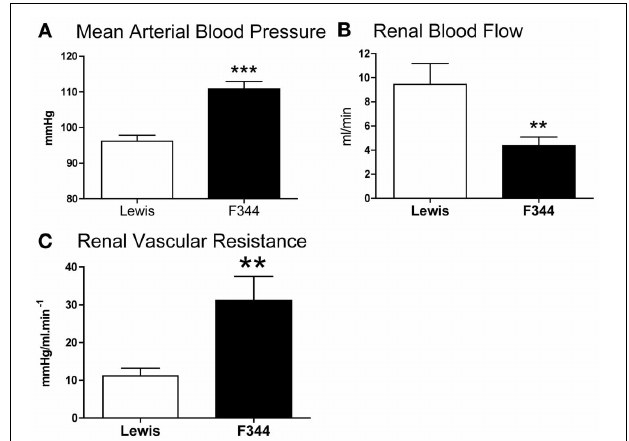
FIGURE 1 | (A) Mean arterial blood pressure; (B) left renal artery blood flow and (C) renal vascular resistance in the left renal artery measured in Lewis ( n = 8; open bars) and F344 ( n = 7; black bars) rats. Data are mean ± SE . Statistical comparisons were made with unpaired t -test. ∗∗∗ P < 0 . 001; ∗∗ P < 0 . 01.